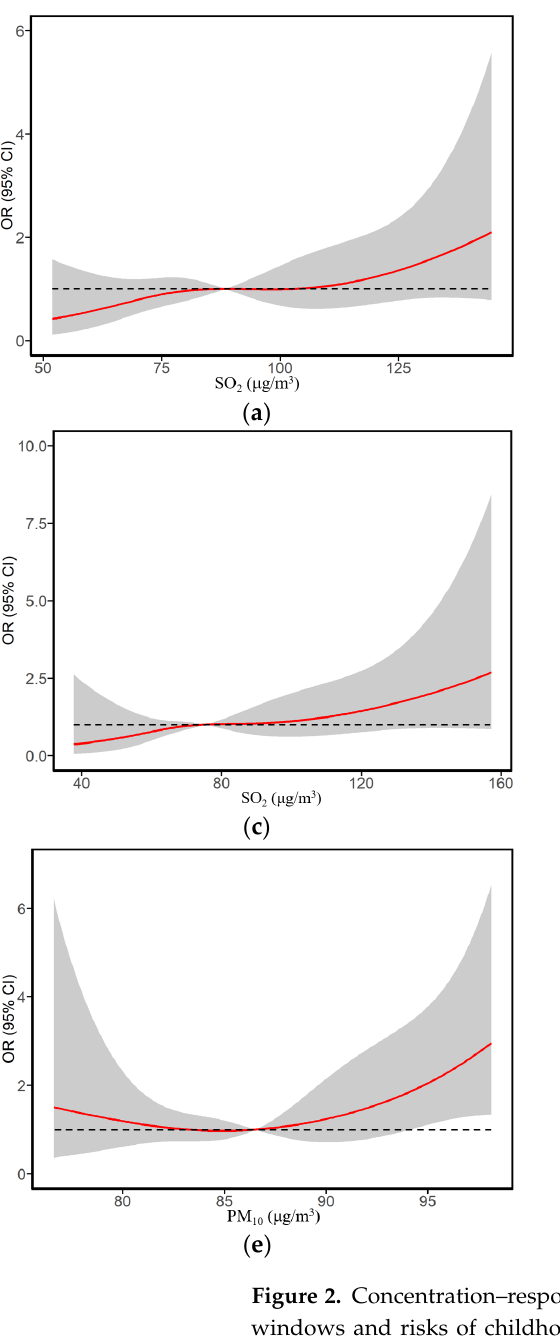
Figure 1. Concentration–response curves between exposure to SO 2 in the 1st trimester and risks of childhood annual SAR to pollen. OR (95% CI) was adjusted for all the covariates in Table 1.